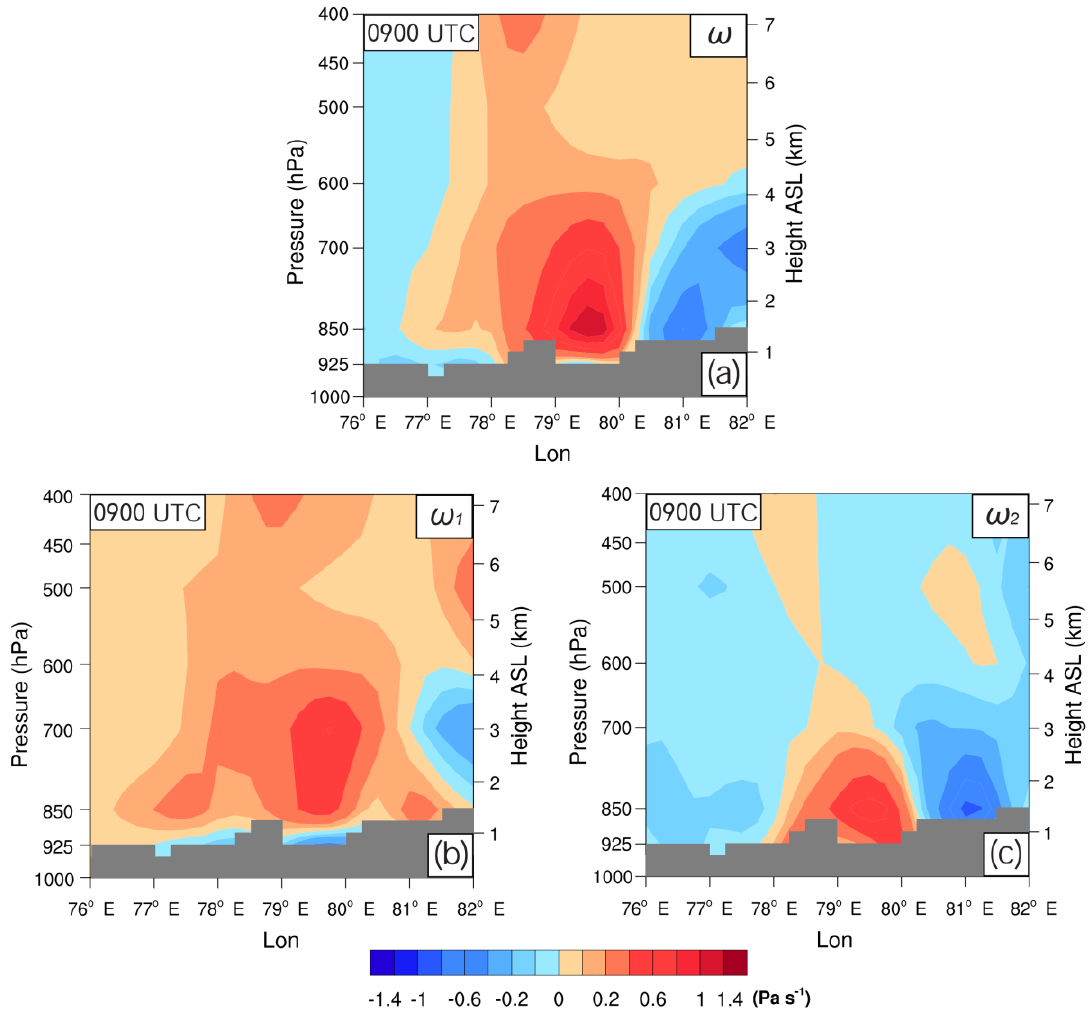
Figure 14. ( a ) Vertical cross section of ω (shading, units: Pa s −1 ) along line A6B6 shown in Figure 12 on 0900 UTC 17 June 2016. ( b ) and ( c ) are the same as ( a ) but for the ω 1 (shading, units: Pa s −1 ) and ω 2 (shading, units: Pa s −1 ), respectively. The dark grey shading shows the area below ground surface.